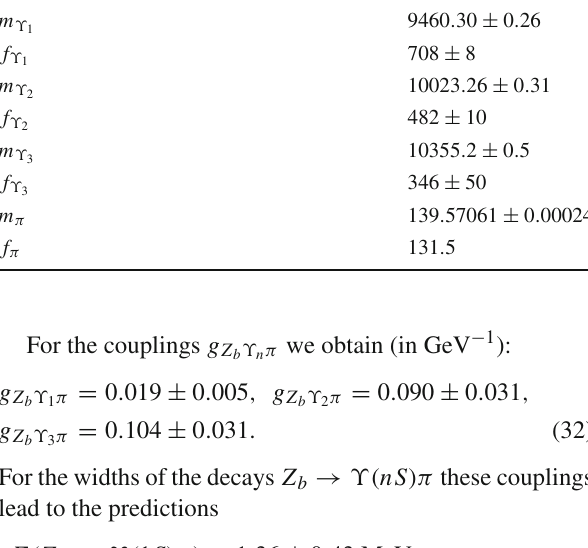
Table 1 Spectroscopic parameters of the mesons ϒ nS and π